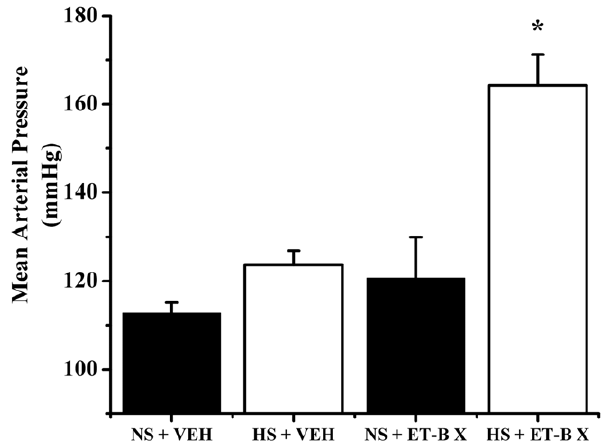
Figure 1. Mean arterial pressure in response to chronic intramedullary blockade of ET-B receptors. Chronic intramedul- lary blockade of ET-B receptors causes a slight increase in MAP in rats on a normal salt diet (112.8 6 2.4 in vehicle vs. 120.7 6 9.3). However, rats placed on high salt diet had a much greater elevation in MAP in response to IM ET-B blockade (123.7 6 3.2 vs. 164.2 6 7.1). * denotes p , .05 vs. all other groups.